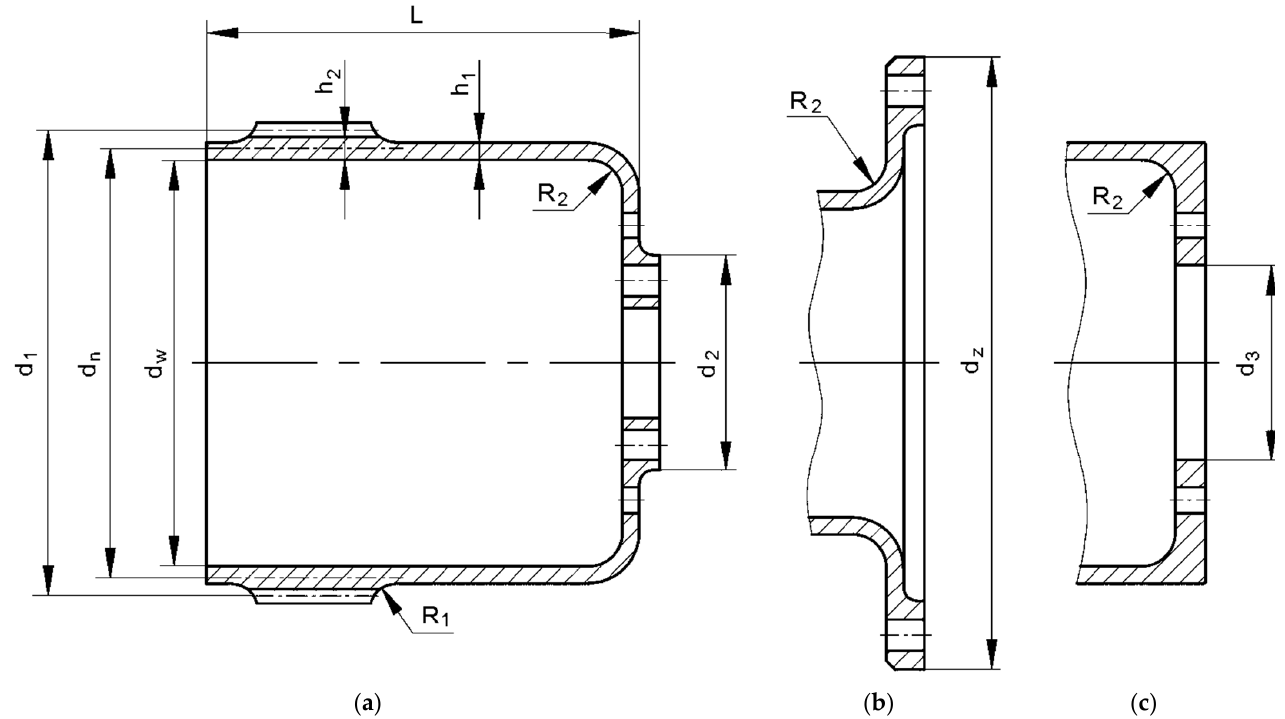
Figure 2. Selected constructions of flexsplines of harmonic drives with: ( a ) bottom, ( b ) outer flange, ( c ) inner flange. Where: d 1 -pitch diameter, L-flexsplinelength, d w —inside diameter, d n —diameter of the neutral layer circle, d 2 —thickening diameter, d z —diameter of the outer flange, d z —diameter of the inner flange, h 1 —sleeve body thickness, h 2 —body thickness without toothed ring, R 1 —radius of toothed rim, R 2 —fillet radius. Own study based on [21].